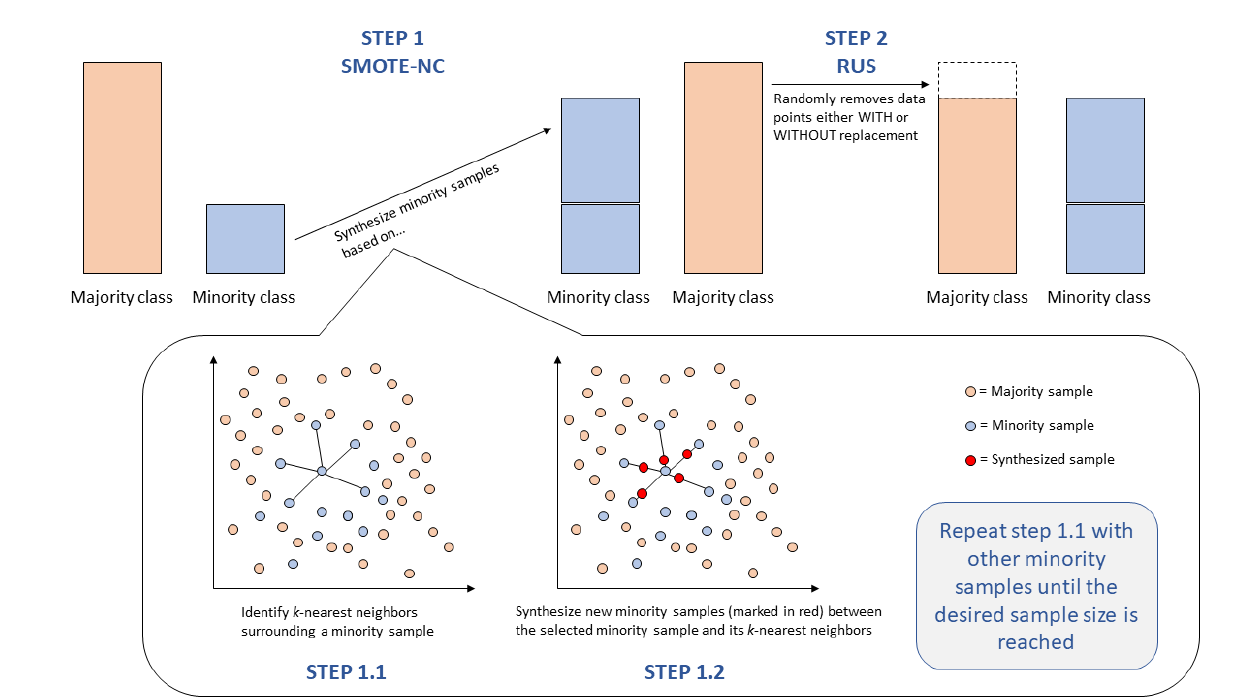
Figure 3. Hybrid resampling